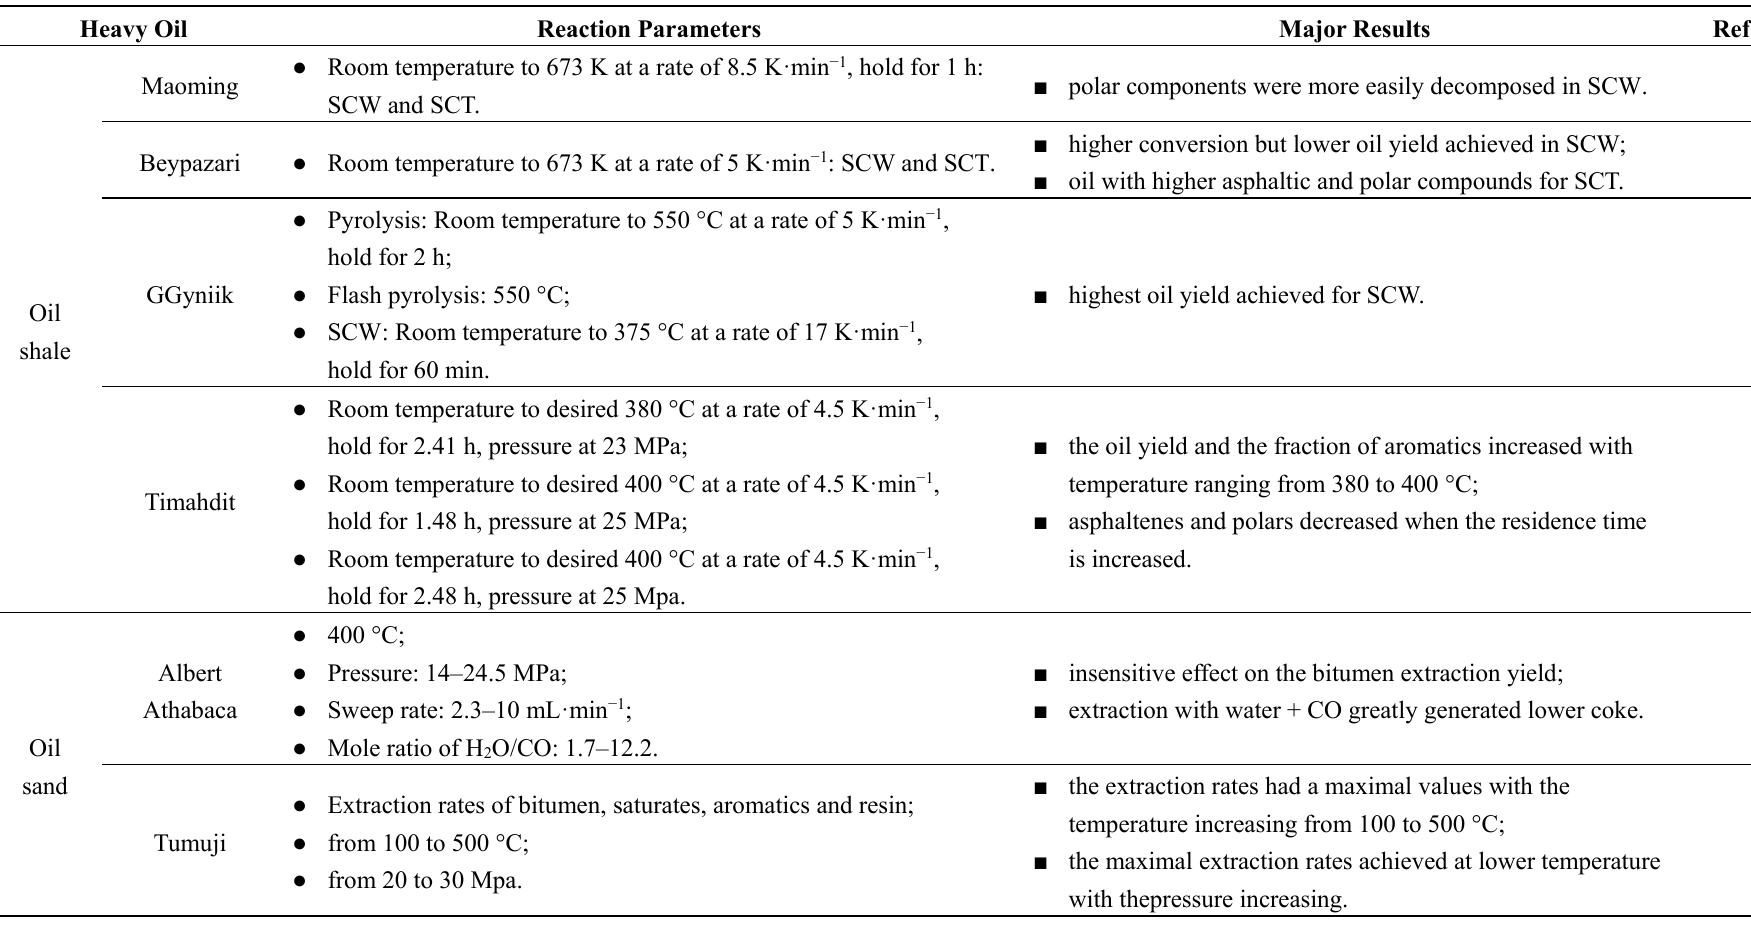
Table 2. Summary of the effects of reaction parameters on the transformation of hydrocarbons from heavy oil source. Heavy